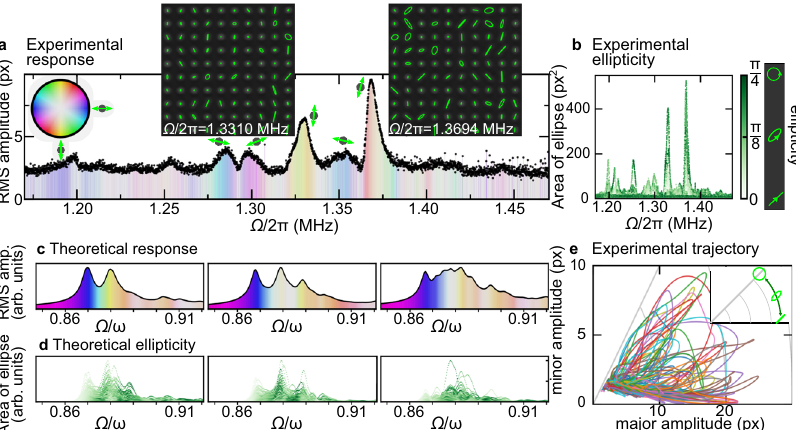
Fig. 4 Evolution of polarization patterns. a Measured RMS amplitude for the pillars in the array vs. drive frequency Ω /2 π . The color wheel illustrates the orientation θ of the pillar trajectories averaged over the whole array (more intense colors indicate larger homogeneity of the orientation). The small insets at each peak re fl ect the average orientation at the maximum of the peak. The experimental steady-state patterns at the two largest peaks are shown as further insets. b Experimental area of the elliptical trajectory for different drive frequencies with color-coded ellipticity ζ . The pictograms next to the color bar illustrate how ellipticity corresponds to the actual form of the trajectory. c Theoretical RMS amplitude for different frequencies displayed in three different random realizations with the same disorder parameters. The color re fl ects the mean orientation of the array at each frequency according to the color wheel in a . d Theoretical area of the elliptical trajectory depending on the drive frequency with color-coded ellipticity as in b for the three disorder realizations in c . e Experimentally determined minor amplitude vs major amplitude of each pillar in the array around the largest peak: (1.36 MHz ≤ Ω / 2 π ≤ 1.38 MHz; data have been smoothed, see Supplementary Note 2 and Supplementary Fig. 3). As shown in the inset, trajectories become more elliptical when moving up from the x -axis to the diagonal. Tight-binding parameter values corresponding to c and d are given in Supplementary Table 1.